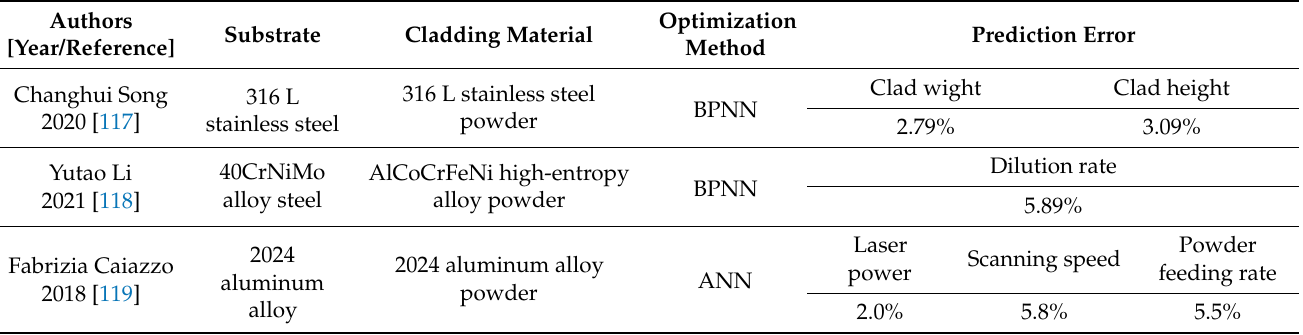
Table 4. Neural network prediction objects and